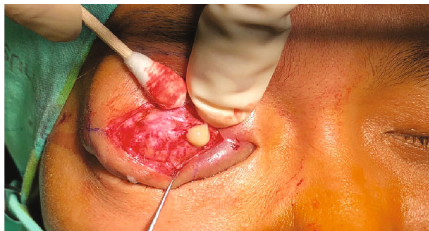
Figure 3: A mass involving the septum and orbital fat with multiple loculated